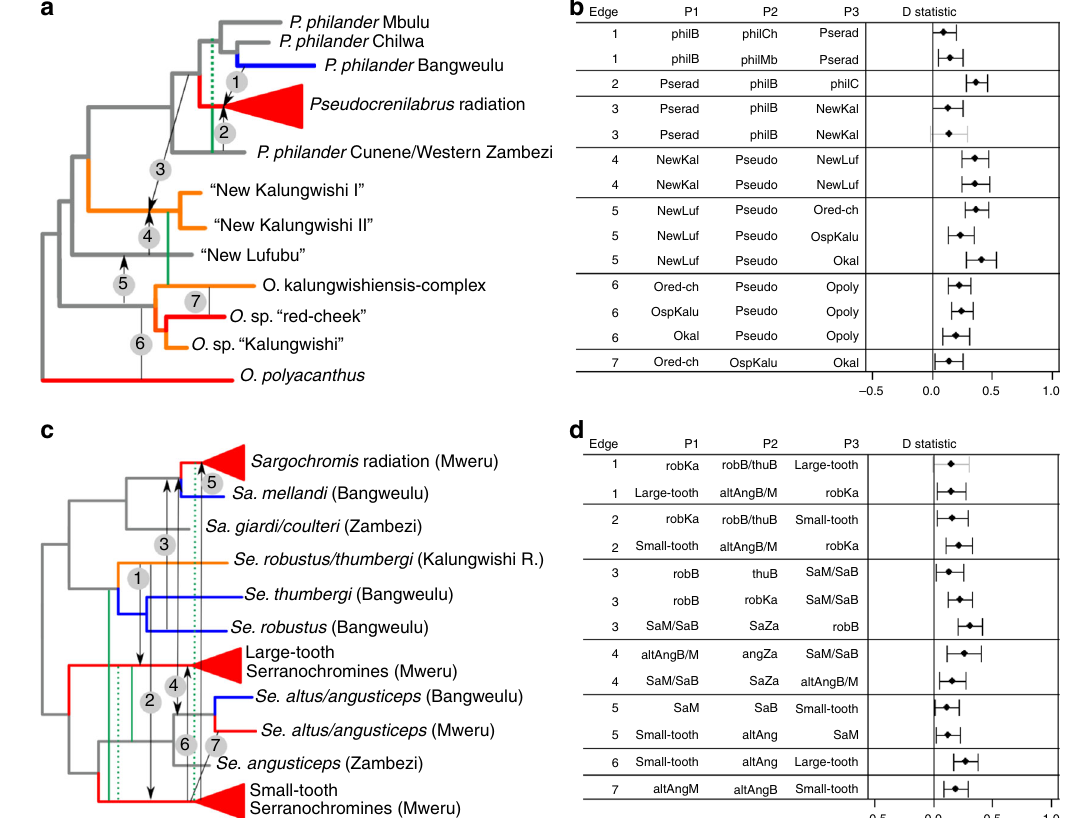
Fig. 3 Cytonuclear discordance and tests of hybridization reveal reticulate ancestry of all Mweru radiations. Nuclear cartoon topology of the “ orthochromines ” ( a ) and serranochromines ( c ) with green vertical lines showing mitochondrial sister relationships that deviate from the nuclear tree (solid lines) and sharing of mitochondrial haplotypes (dashed lines). Lake Mweru taxa are highlighted with red edges and radiations are shown as triangles, whereas Lake Bangweulu taxa are shown with blue edges. Riverine taxa in the drainage system of Lake Mweru are shown with orange edges. Black vertical lines indicate evidence for hybridization from D statistics (numbered as shown in b and d ) and other tests of hybridization. Where data allow, arrow heads indicate the putative direction of gene fl ow. b and d D statistic results supporting hybridization edges shown in a and c for “ orthochromines ” and serranochromines, respectively. Error bars indicate three standard deviations from the mean and are depicted in grey if overlapping with 0 (non-signi fi cant, | z | < 3). D statistics and z -scores are averaged across multiple tests with different outgroups. Tests for edges 4 – 6 in b show averages of tests using Pseudocrenilabrus from Lake Mweru, Bangweulu or from the Zambezi/Cunene as P2 as they were all very similar. Likewise, tests where two groups are given for P2 or P3 revealed very similar results for both groups and have thus been averaged. All D statistics used to compute the averages are provided as Supplementary Data 2 – 4 and 7 – 8. R scripts and the data underlying the fi gures are provided at Zenodo with